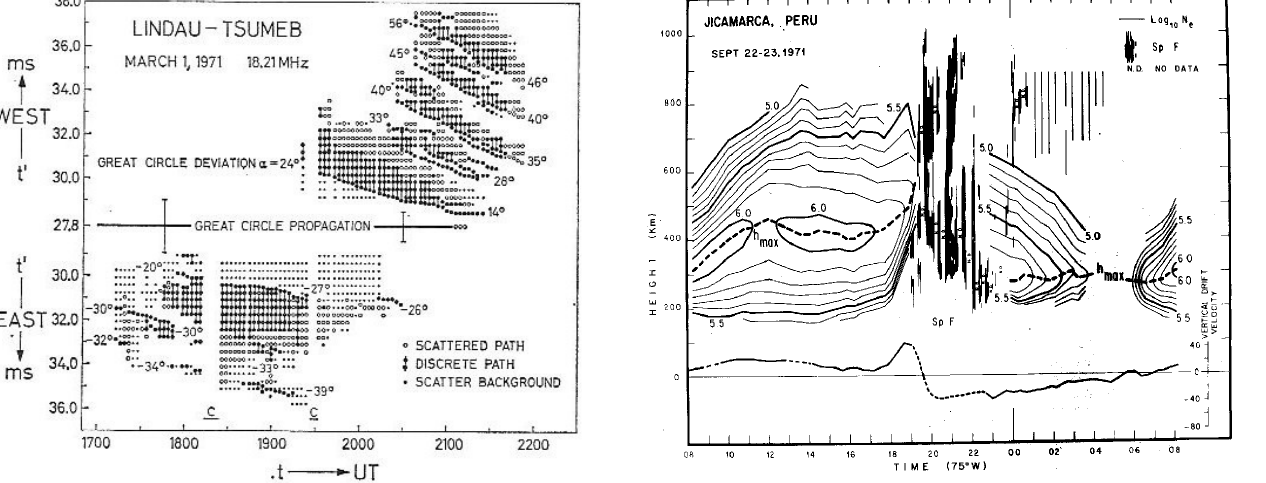
Figure 5. Propagation delay characteristics of a trans-equatorial link between Lindau and Tsuneb (after Roettger, 1973). Note the diffuse nature of the delays clustered in distinct groups with, delays larger than the one corresponding to the great circle. The degrees label on each cluster correspond to the deviation angle of the propagation path with respect to the great circle.